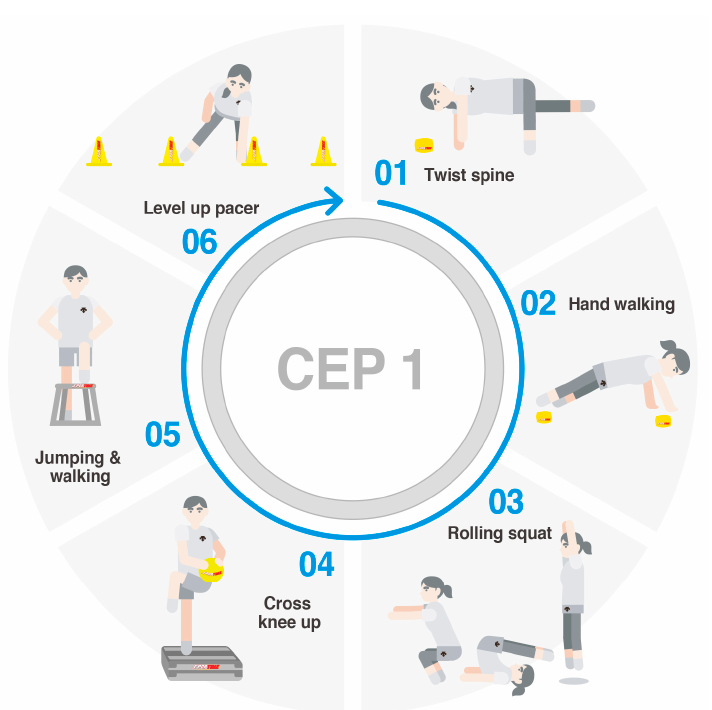
Figure A1. The sequence of motions for circuit exercise program 1: (1) Twist spine, (2) Hand walking, (3) Rolling squat, (4) Cross knee-up, (5) Jumping & walking, (6) Level-up pacer.